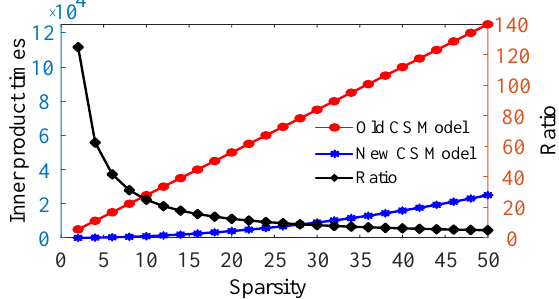
Figure 2. Comparison of the number of times to calculate the residuals and the inner product of the column vectors of the sensing matrix for two compressed sensing models.